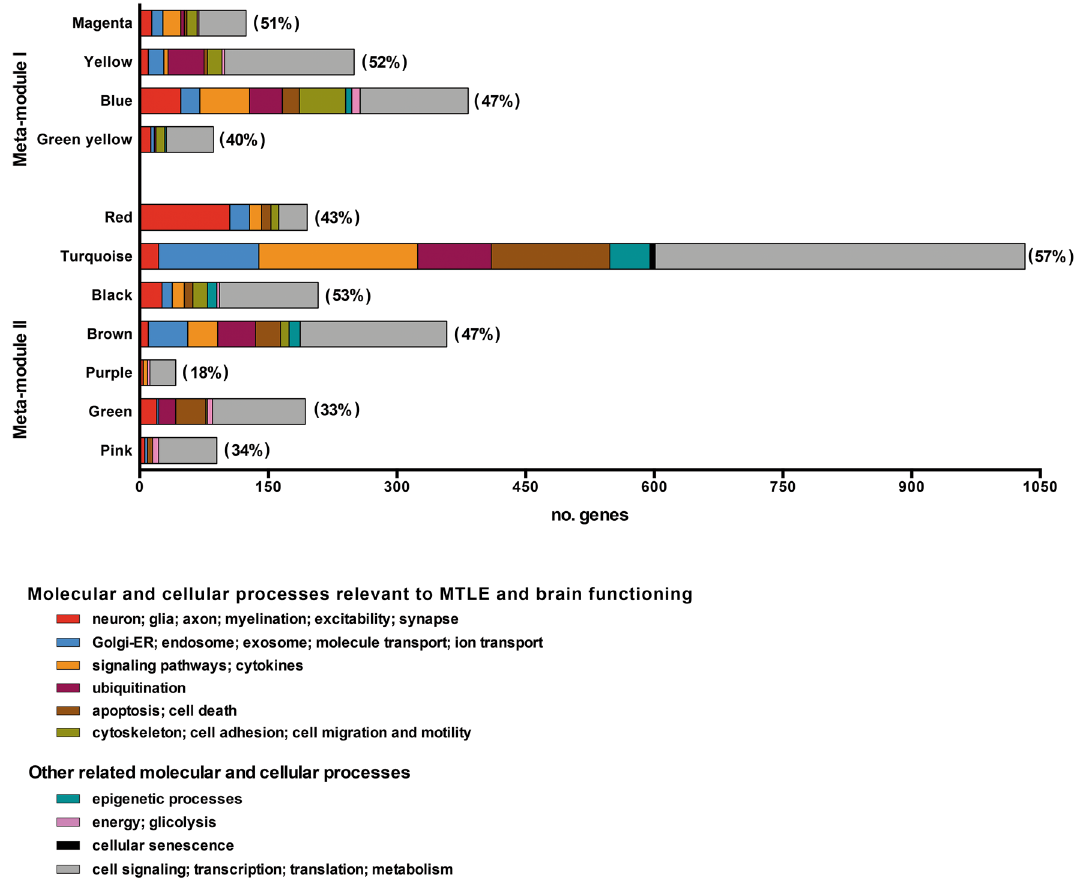
Figure 3. Histogram of enriched GO Biological Process (BP) terms for each WGCNA gene module. Different colors represent GO BP terms comprised in two main categories: (i) molecular and cellular processes